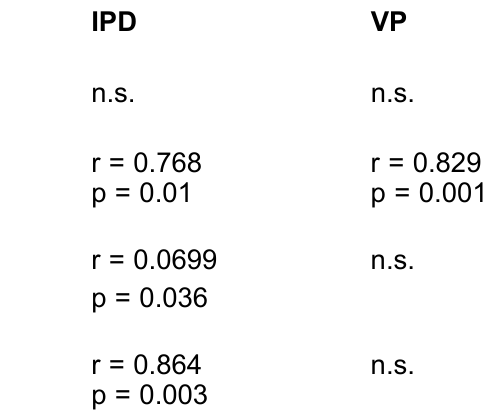
Table 3. Associations between concentrations of neopterin and cytokines in plasma and CSF of controls, patients with idiopathic Parkinson's disease (IPD) and vascular parkinsonism (VP) (Pearson's correlations coefficients and p-vales are shown; ns. = not